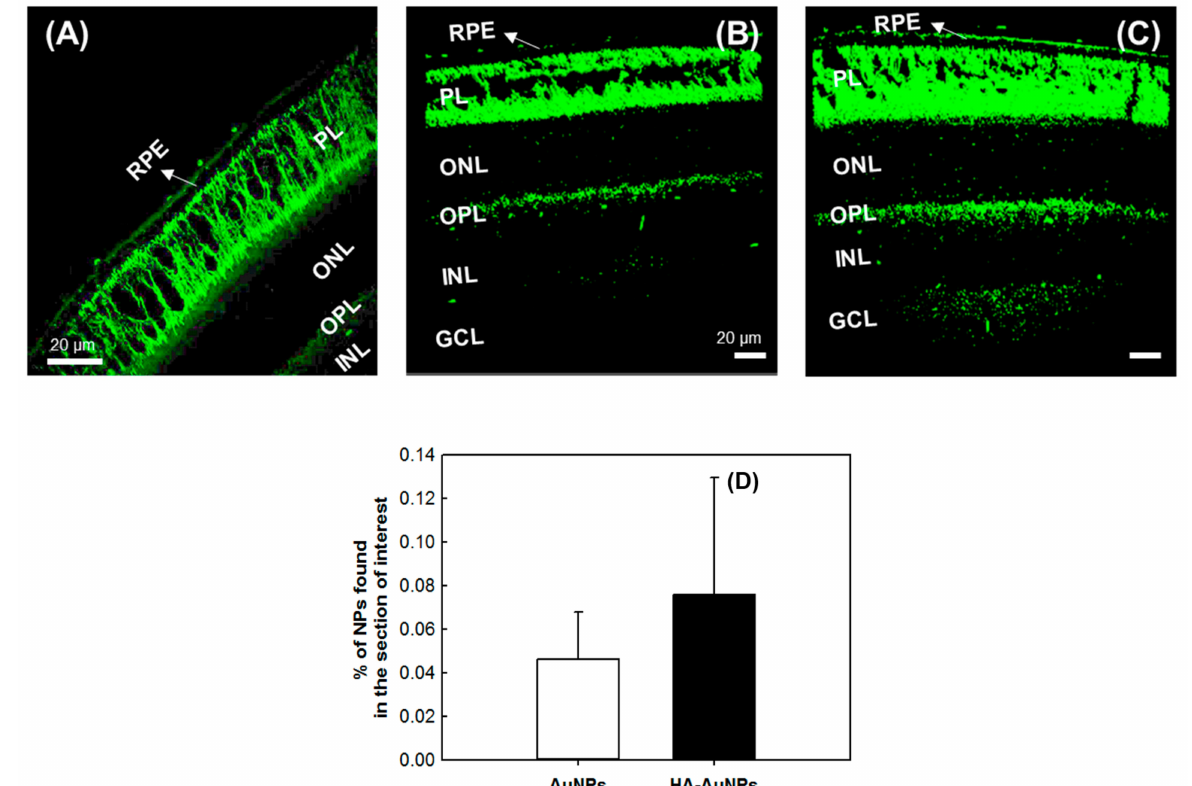
Figure 1. Confocal microscopy images of retinal sections from non-treated mice as a control sample ( A ), animals treated with AuNPs ( B ), and HA-AuNPs ( C ). Resultingly, ~50% more HA-AuNPs were detected in the retina within 5 min ( D ). ( n = 3). RPE: retinal pigment epithelium, PL: photoreceptors layer, ONL: outer nuclear layer, OPL: outer plexiform layer, INL: inner nuclear layer, GCL: ganglion cell